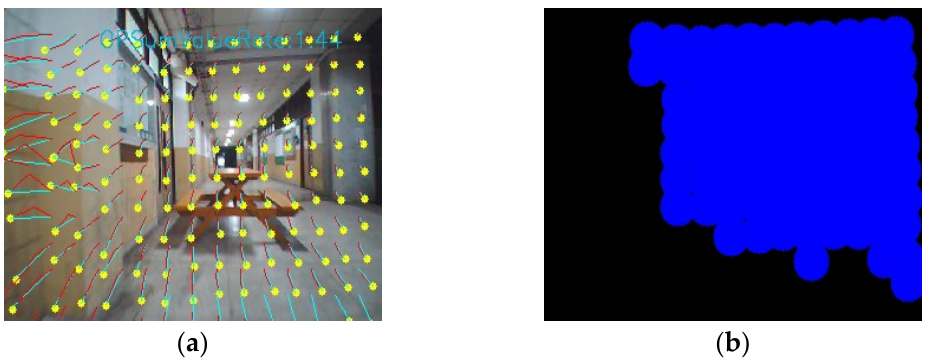
Figure 4. Multi-thread KLT flow on the image sequence. In this example, there are three threads, and each thread will uniformly redraw the points in every three frames (frames with orange dots). The blue arrows illustrate the estimated optical flow vectors of the drawn orange points.